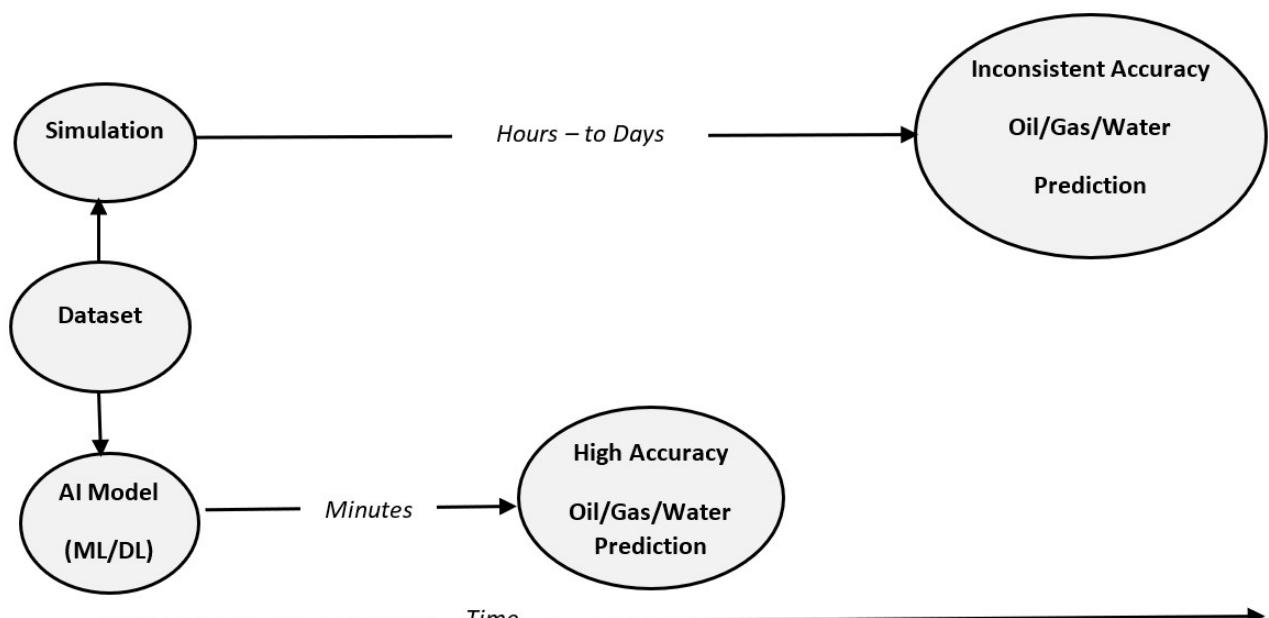
Figure 1. Abstract view of the problem and the proposed solution.